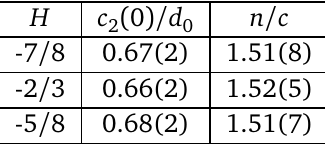
( 0 ) / d and ratio of the spin field multiplicity n σ to the 2 0